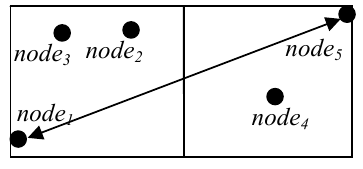
Figure 1. Example of virtual grid in GAF.